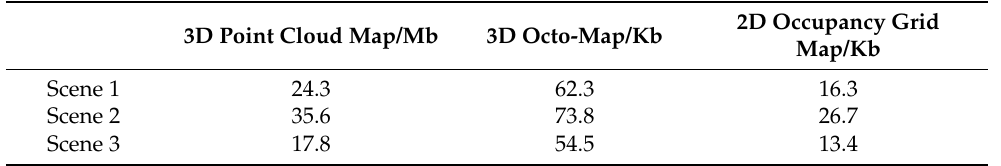
Table 5. The memory occupied by the constructed point cloud map, 3D octo-map, and 2D occu- pancy grid map constructed for the three scenes.